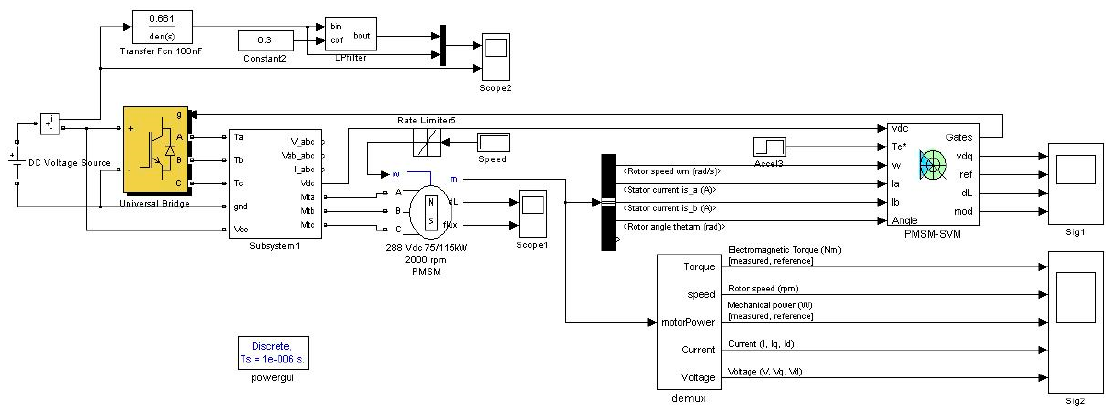
Figure 6. Simulation model.